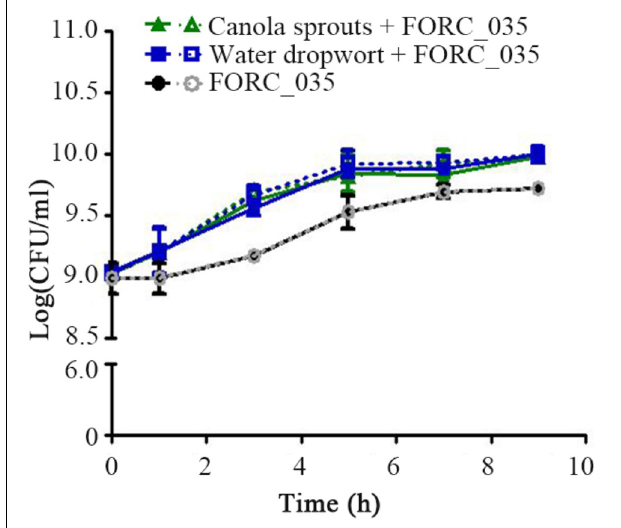
FIGURE 1 | Growth of FORC_035 in M9 minimal media with or without fresh produce. Bacterial cells were inoculated at 10 9 CFU/mL to fresh M9 minimal media containing canola sprouts or water dropwort, respectively. As a control, FORC_035 was cultivated in M9 minimal medium without plant material. In order to discriminate E. coli among indigenous bacteria of plant tissues, culture suspension was diluted and spread onto E. coli selective TBX agar (dotted line) and LB agar (solid line), simultaneously. When only plants were incubated, growth of E. coli was not detected ( Supplementary Figure S2 ). Each symbol indicates the mean value from triplicate